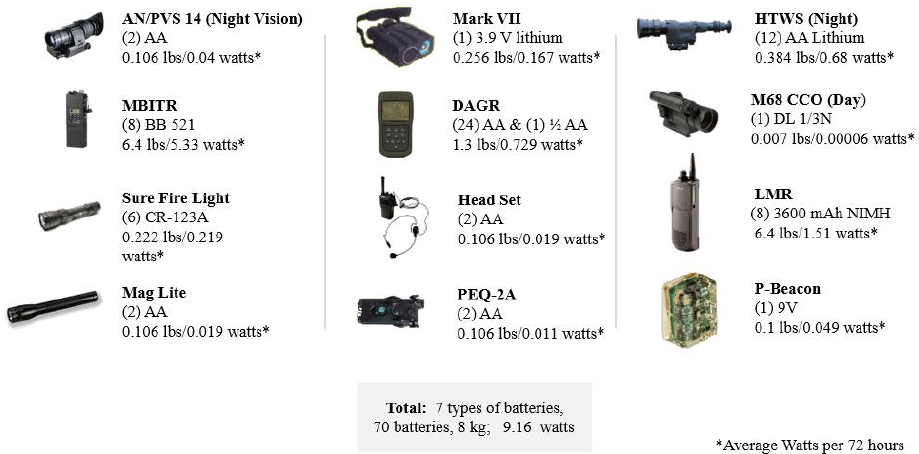
Figure 1. Average equipment of a soldier. Source: [8].